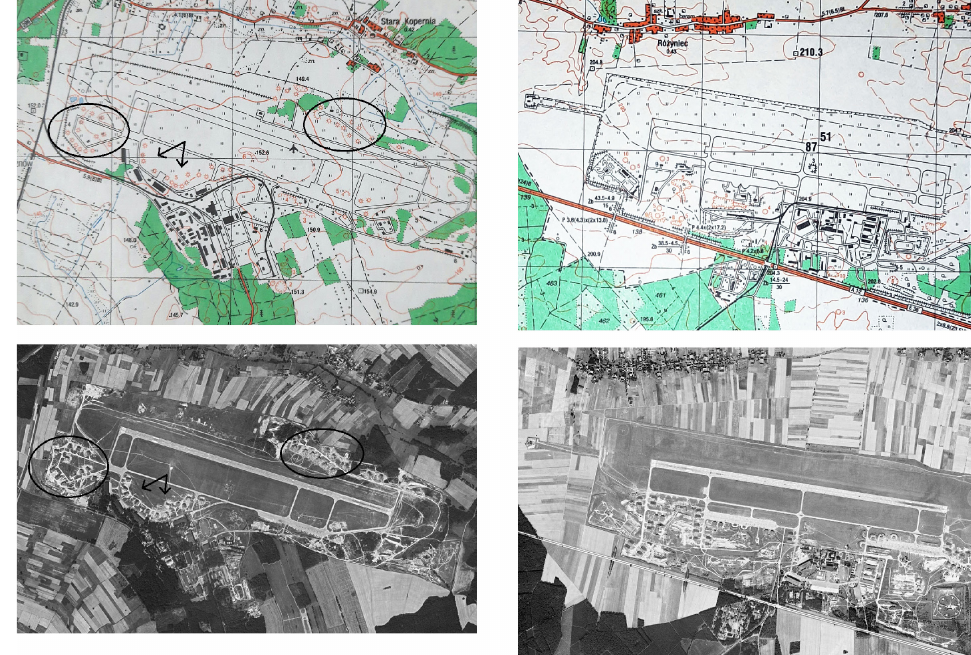
Fig. 15. The differences between the ways of presenting the aircraft shelters on the maps “Model 1990”: on the left − the marking “mound” at the Stara Kopernia airfield, on the right − no markings at the Krzywa airfield. Below are images of the airfields taken by the KH-7 satellite in the late